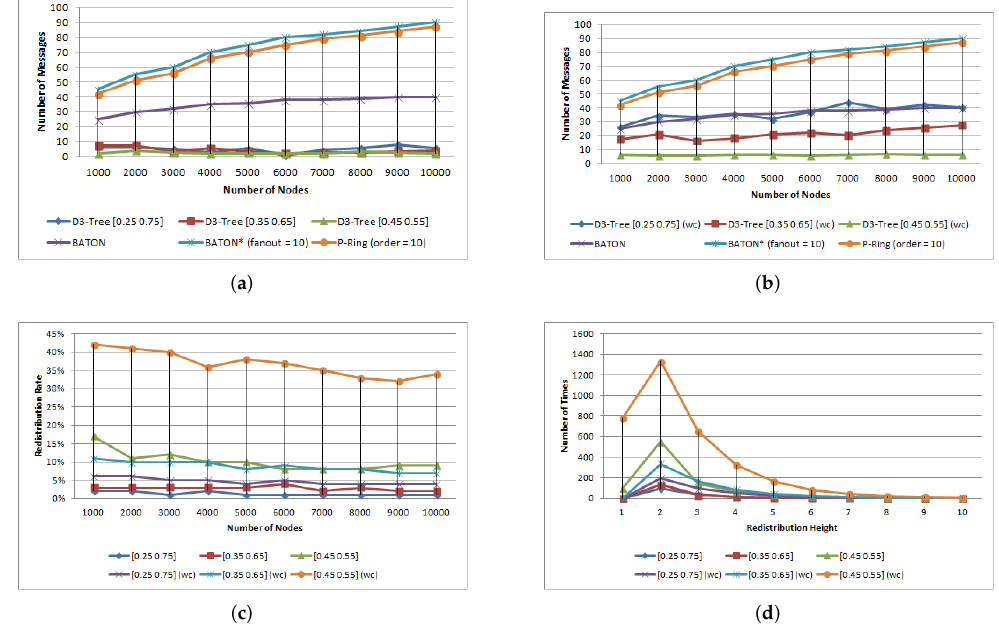
Figure 6. Node update operations. ( a ) average case, ( b ) worst case, ( c ) redistribution rate of winner D 3 -Tree, ( d ) redistr/ion height of winner D 3